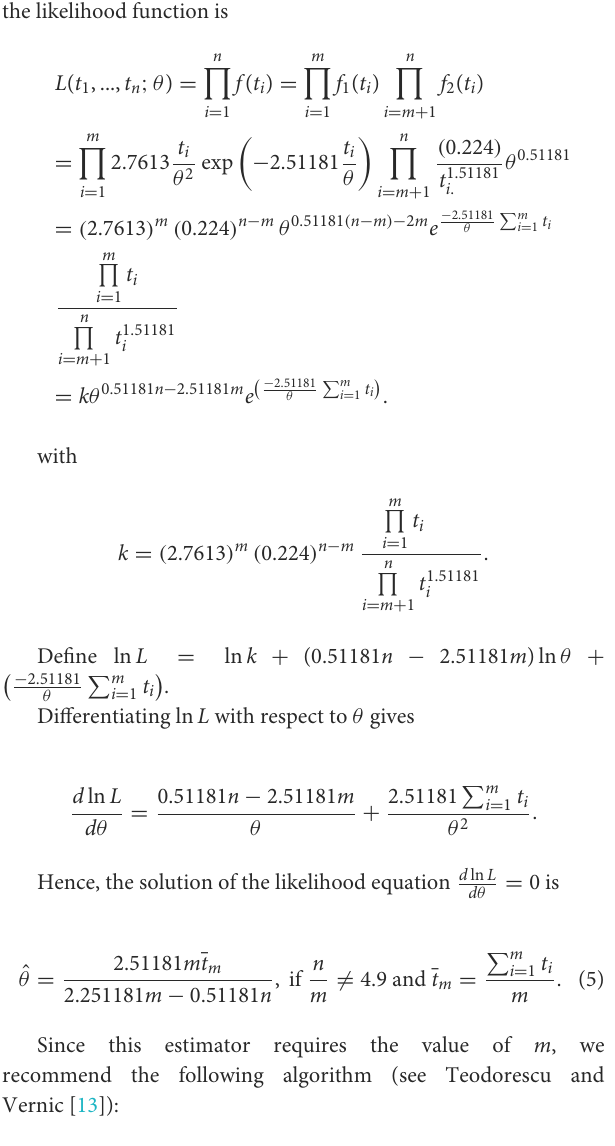
Algorithm 1. Estimate θ using MLE.